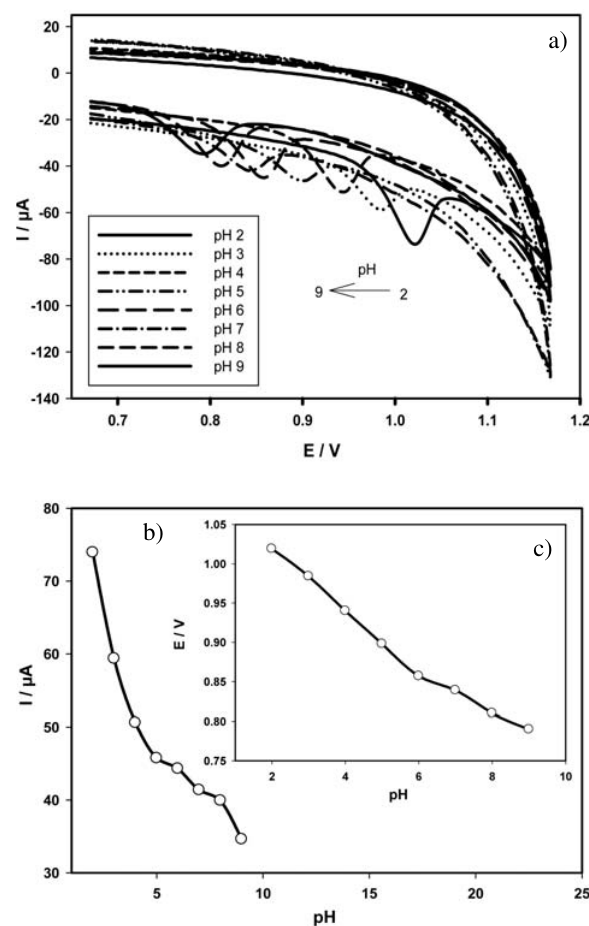
Figure 5: Cyclic voltammograms of 1.0 × 10 –3 mol/L MET at PY- CPE in BR buffers (2.0–9.0) (A). Relation between anodic peak cur- rent of 1.0 × 10 –3 mol/L MET and pH (B) and inset: Relation bet- ween anodic peak potentials (C) of 1.0 × 10 –3 mol/L MET and pH.